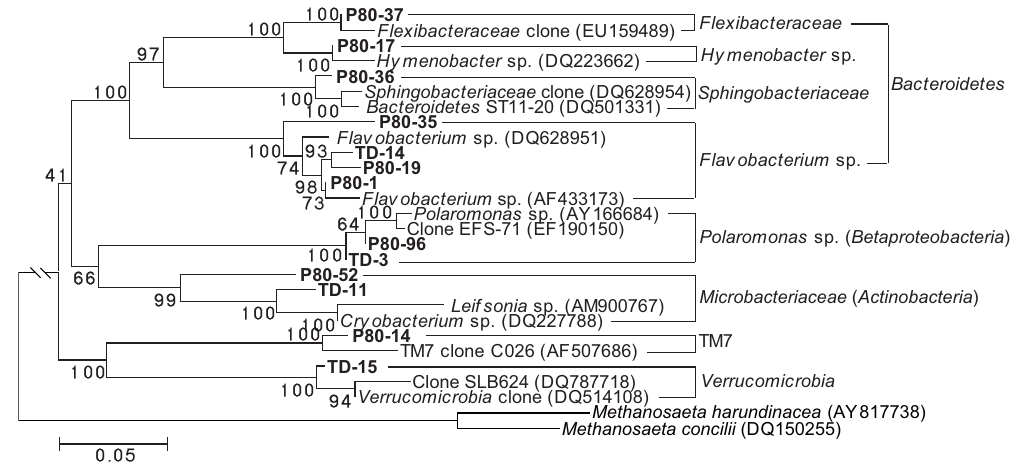
Fig. 3e. Phylogenetic analysis of the 16S rRNA genes for the Bacteroidetes , Betaproteobacteria , Actinobacteria , TM7, and Verrucomicrobia clones (with later portion of the 16S rRNA gene sequences, corresponding to regions 800–1452 of the Escherichia coli 16S rRNA molecule) from the Puruogangri and Dunde Glaciers and the closest relatives. The tree was constructed by following the protocol as described in Fig. 3a. Scale bar indicated 0.05 substitutions per